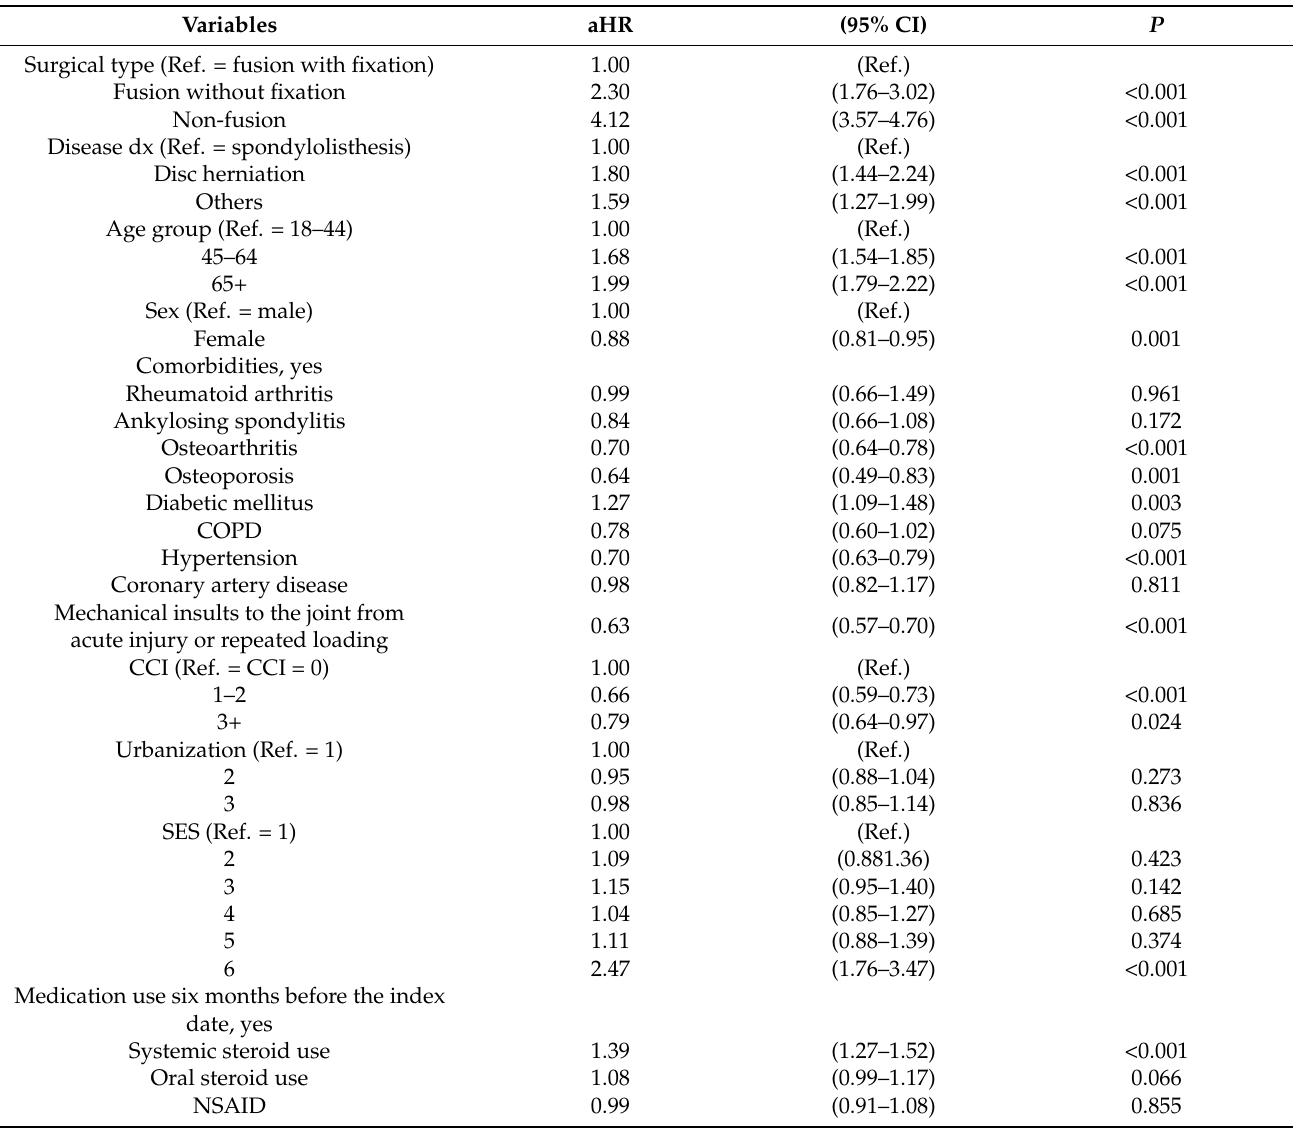
Table 3. Factors associated with the risk of 1-year spine reoperation based on multivariate Cox regression